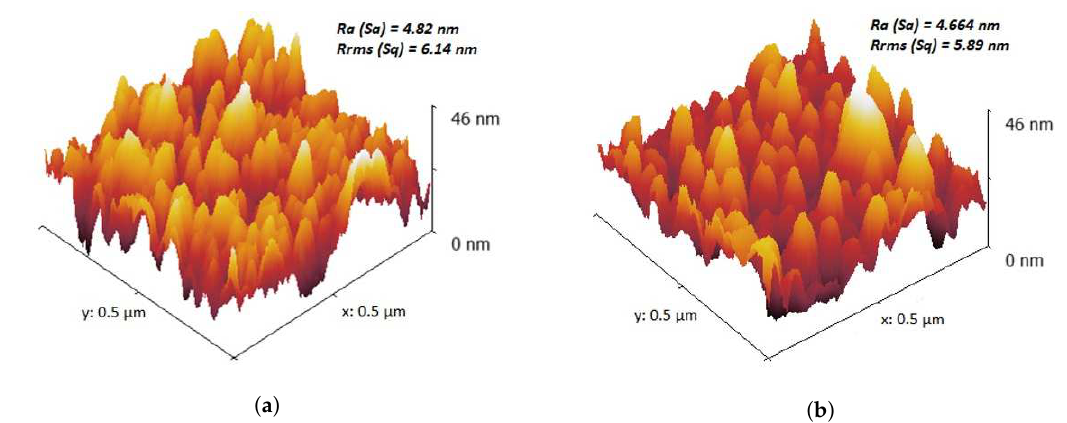
Figure 4. AFM images of NiO F before and after ozonation (60 min of ozonation): ( a ) NiO ( F ) . ( b ) O 3 - NiO ( F ) .